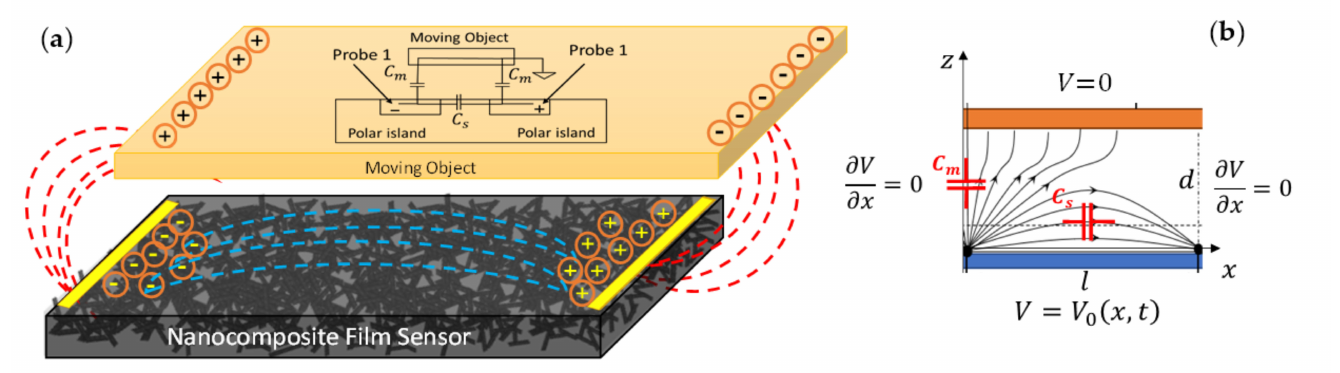
Figure 2. Schematic illustration of sensor mechanism for fringe-based TPU-CNT proximity sensor: ( a ) 3D model, charge distribution and fringe fields while object is in vicinity of the film sensor. ( b ) Symmetric cross section of the rectangular-shaped sensor model with cartesian coordinate system demonstrates boundary conditions